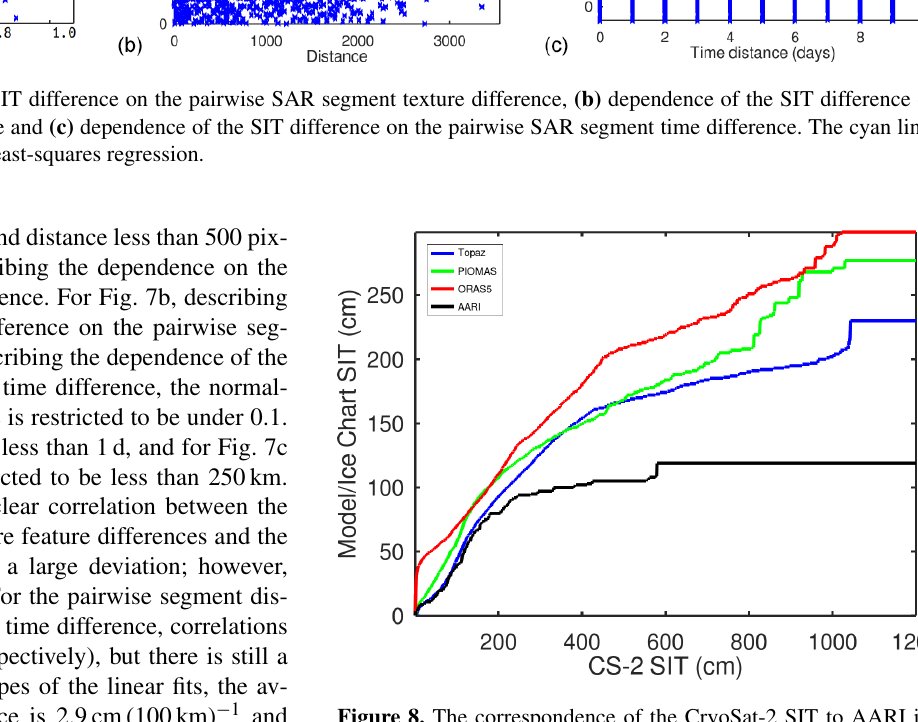
Figure 8. The correspondence of the CryoSat-2 SIT to AARI ice chart SIT and modelled SIT from the three models studied based on histogram